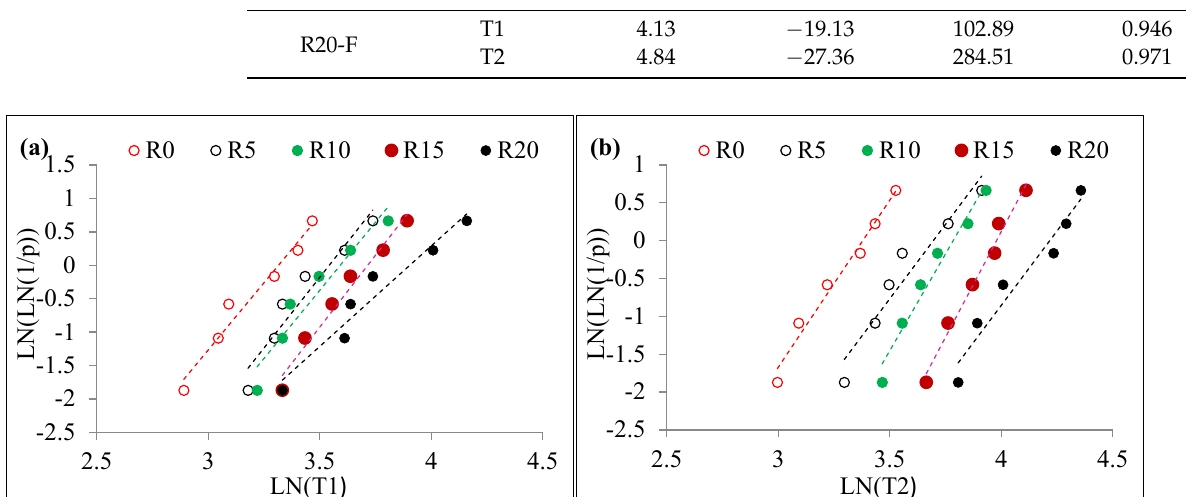
Figure 11. Weibull lines for non-fibrous specimens ( a ) T1 and ( b ) T2.